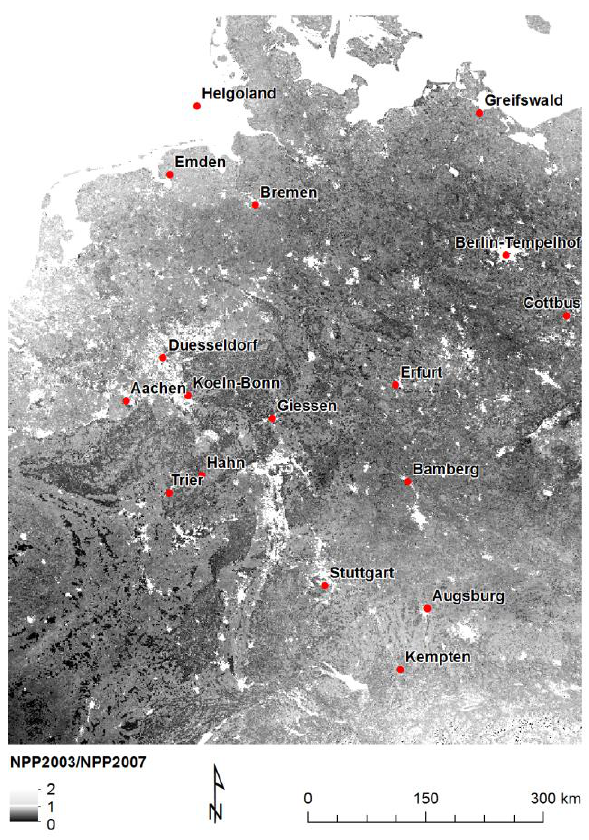
Figure 9. Ratio of MODIS NPP 2003 and